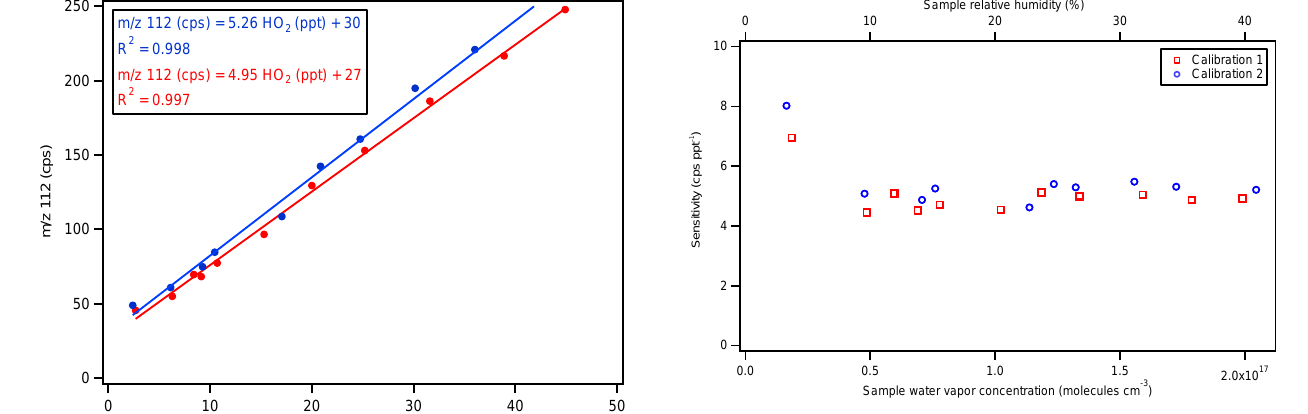
Figure 3. Instrument sensitivity as measured at m/z 112 (cid:0) 79 Br − (HO (cid:1) as a function of sample relative humidity. The in- 2 ) strument sensitivity demonstrates no water vapor dependence be- yond a sample relative humidity of 10%. The “Calibration 1” and “Calibration 2” labels refer to the curves in Fig.